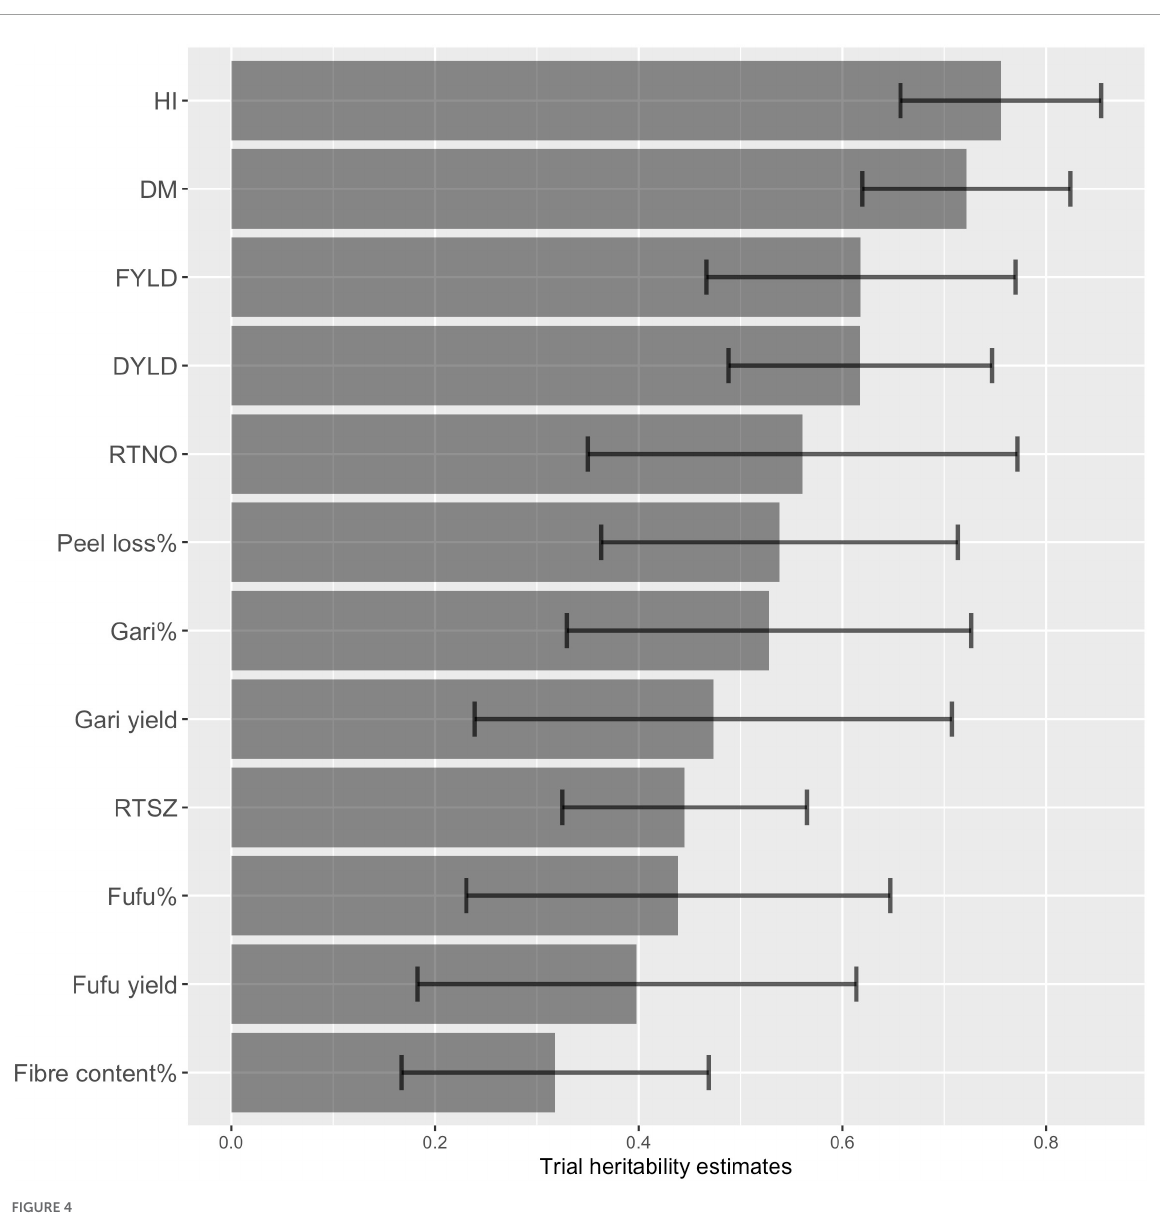
observed an equivalent proportion of TSS explained by residual and genotype terms for all traits except for HI which had a lower % explained by the residual